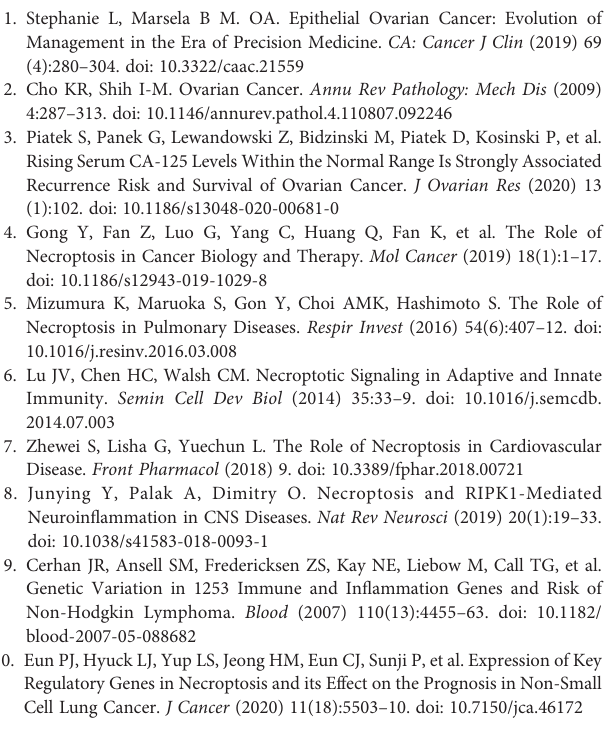
Supplementary Figure 10 | Chemosensitivity and stemness of different groups (A) IC50 of multiple chemotherapy drugs between groups (B) Correlation between the risk genes and chemotherapy drugs (C) Assessment of the association of stemness and risk score.